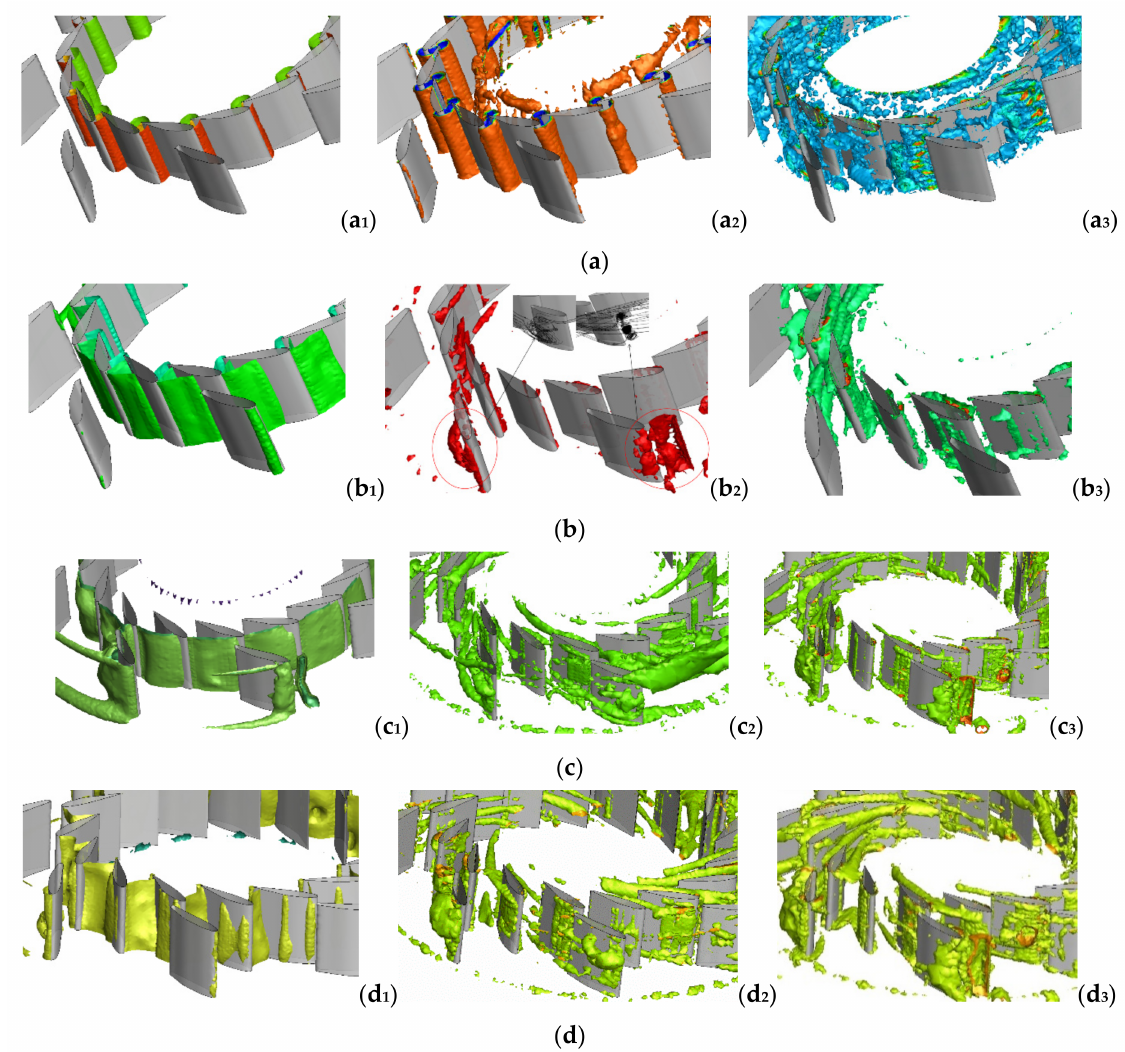
Figure 10. Vortexes in guide vanes. ( a ) α = 13.50 mm (small opening condition): ( a 1 ) Pressure iso-surface method, ( a 2 ) Q criterion, ( a 3 ) Liutex; ( b ) α = 26.17 mm: ( b 1 ) Pressure iso-surface method, ( b 2 ) Q criterion ( b 3 ) Liutex; ( c ) α = 38.05 mm: ( c 1 ) Pressure iso-surface method, ( c 2 ) Q criterion, ( c 3 ) Liutex; ( d ) α = 48.74 mm (optimal condition): ( d 1 ) Pressure iso-surface method, ( d 2 ) Q criterion, ( d 3 )